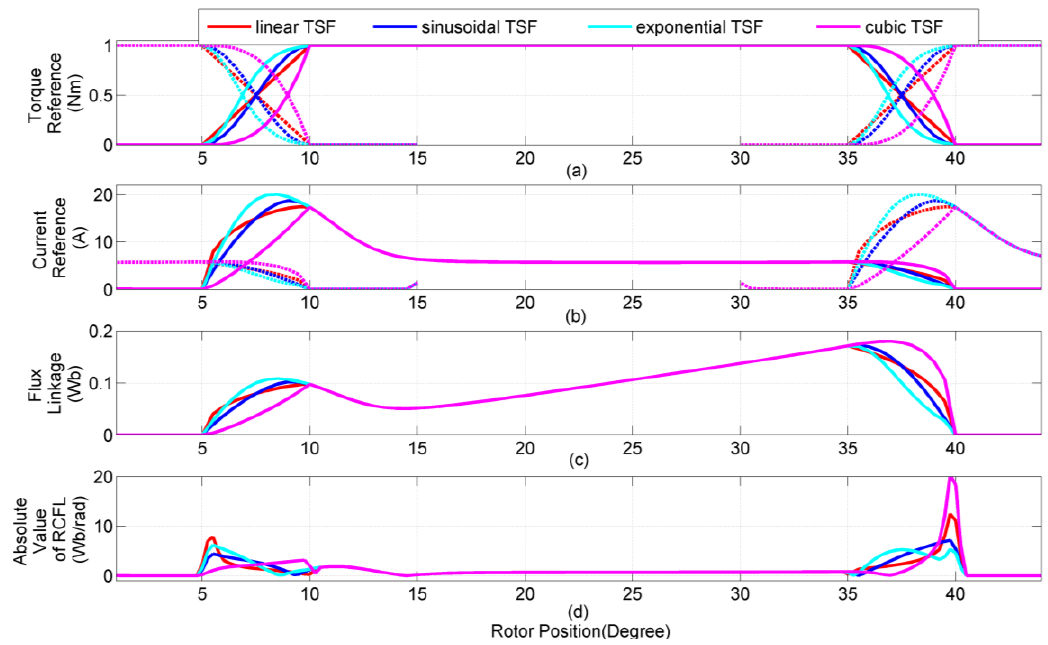
Figure 5. Typical profiles of four conventional TSFs. ( a ) Torque Reference; ( b ) Current Reference; ( c ) Flux Linkage; ( d ) Absolute Value of RCFL.